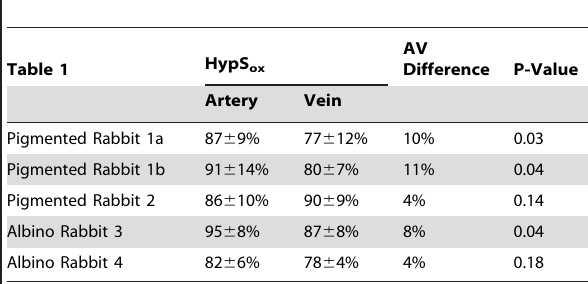
Table 1. Comparison of arterial and venous HypS ox measurements and arteriovenous (AV) differences from 4 rabbits (2 albino and 2